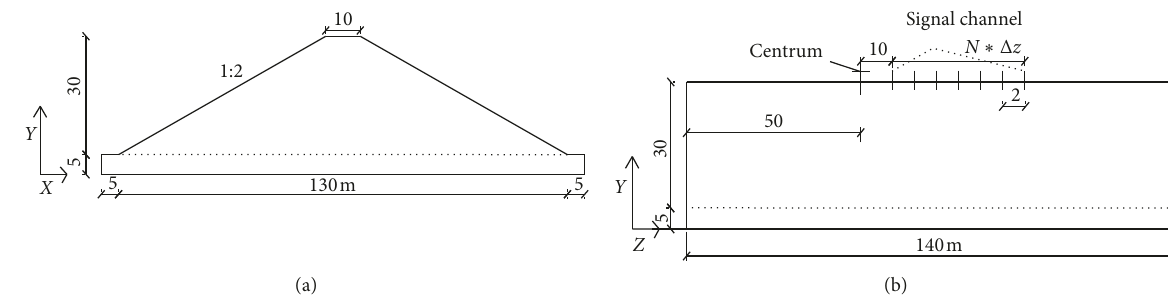
Figure 1: Schematic diagram for size of the finite element model of a hazard-free earth-rock dam. (a) Transverse section. (b) Longitudinal section.